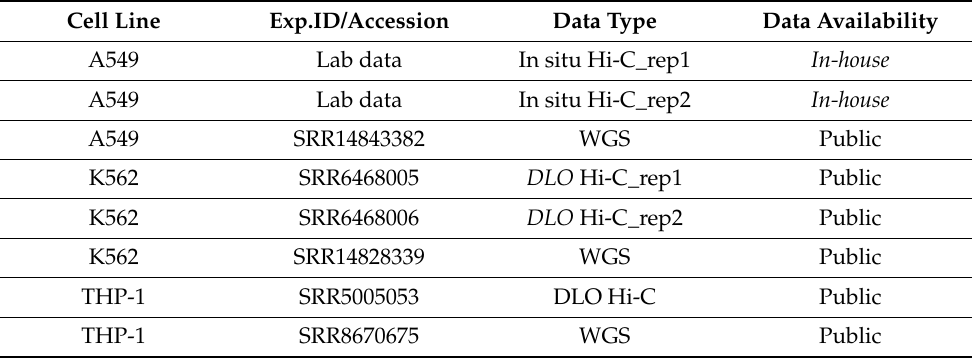
Table 1. Detailed summary of the datasets used for analyses. The following table gives the accession number, cell line, and datatypes of the samples used in this